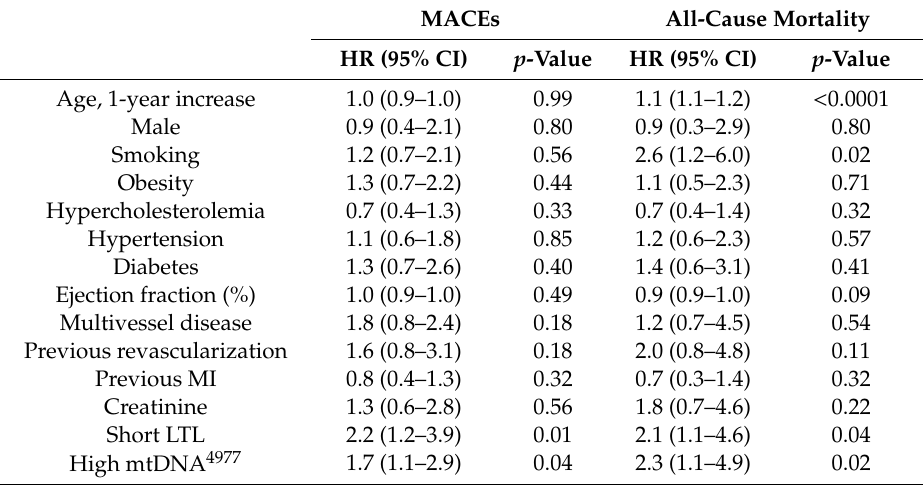
Table 2. Multivariate Cox regression analysis of the association of LTL and mtDNA 4977 with major adverse cardiovascular events (MACEs) and all-cause